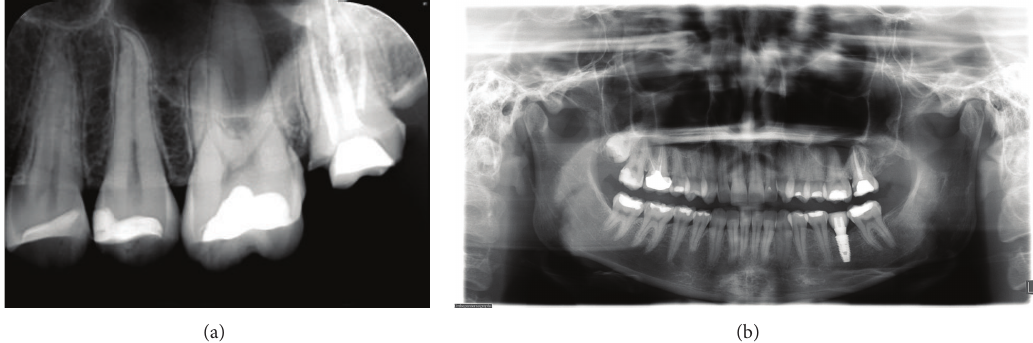
Figure 3: (a) and (b) Periapical and panoramic films show no evidence of lesion in the upper region of left second molar.